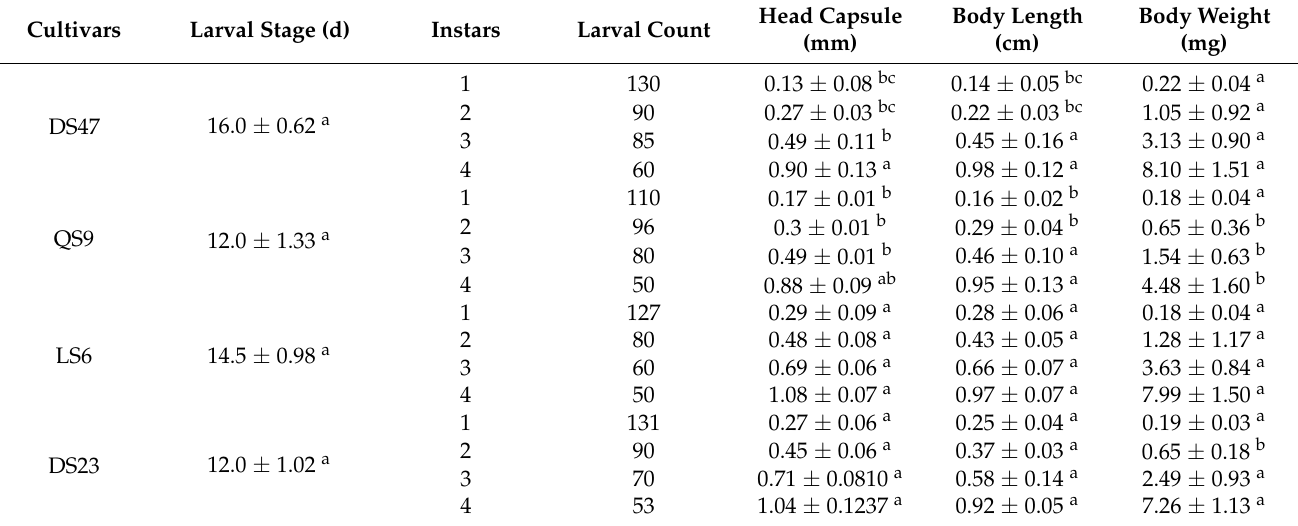
Table 1. Growth and development of potato tuber moth (PTM) larval instars fed on different varie- ties of potato leaves.